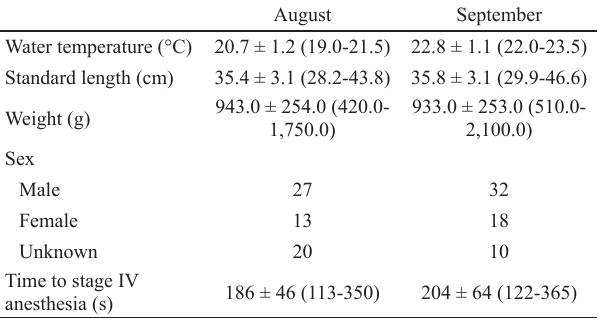
Table 1. Biometric data of Prochilodus lineatus , water temperature, and induction time to stage IV anesthesia (mean, ± SD, range) at the two experimental periods.